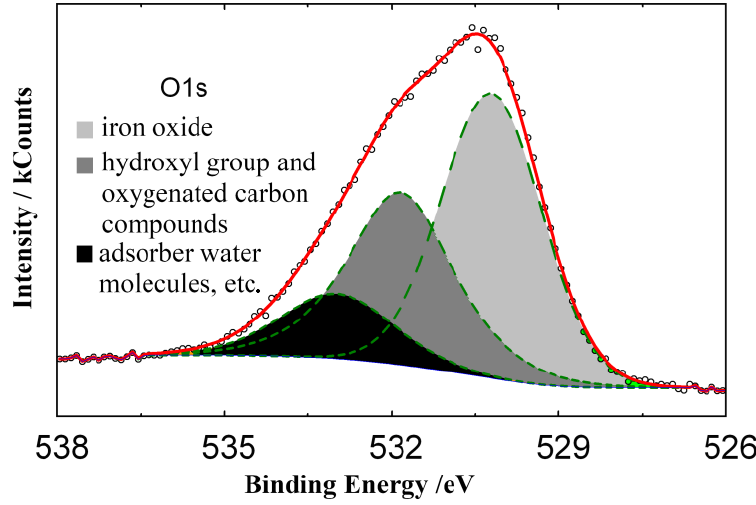
Figure 10. XPS spectra of O1s electrons on the steel surface after preliminary inhibitor adsorption (2.0 M HCl + 5.0 mmol TA, 25 °C, 24 h).